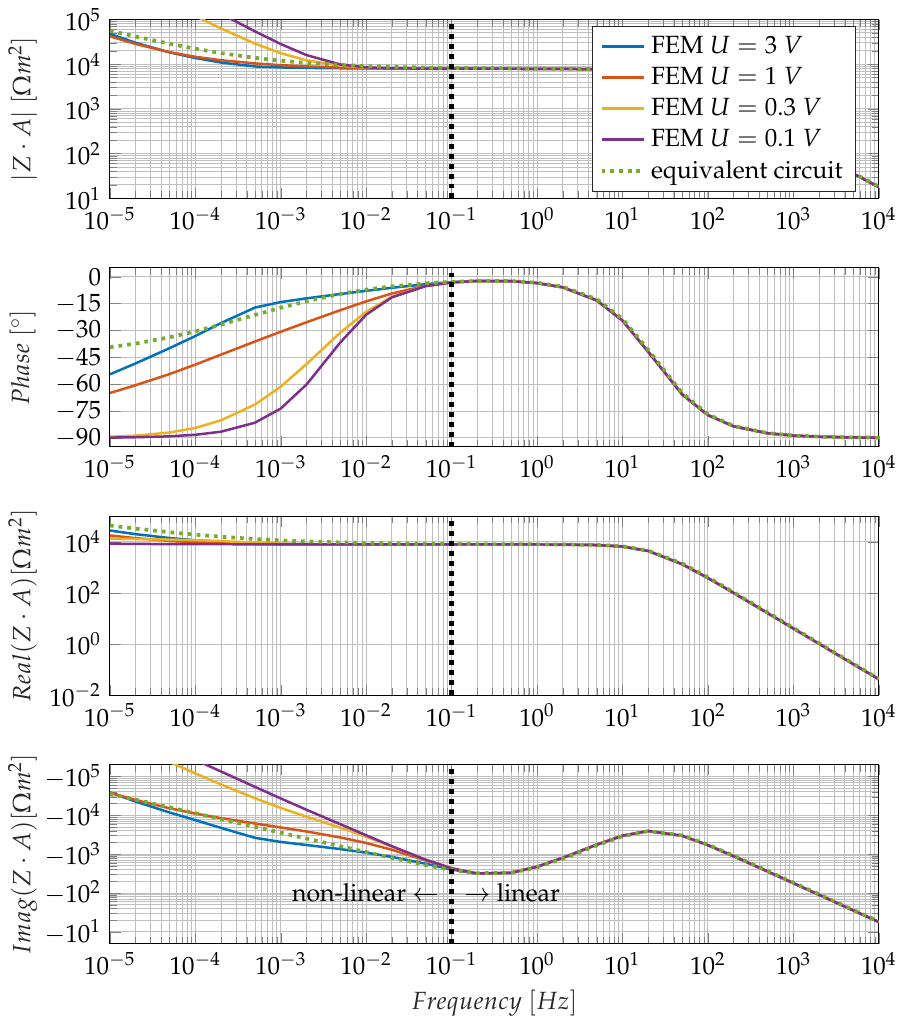
Figure 3. Impedance spectrum of the one-dimensional FEM model. The limit cycles from Figure 2 are marked in the impedance spectrum. The spectrum neglects higher harmonic components and uses the fundamental oscillation of the electrical current for impedance calculation at each frequency. The fitted √ equivalent circuit uses the parameters C = 860nFm − 2 , R 2 = 7910 Ω m 2 , A 2 = 400 Ω Hzm 2 . In contrast to the one-dimensional FEM model considered so far, interdigitated elec- trodes have a predominantly two-dimensional field distribution. In the area of the finger- tips, the field distribution is even three-dimensional. Especially in interdigitated structures with a very large electrode width compared to the gap width, the electric field strengths between the electrodes are considerably larger than the electric field strengths perpendicu- lar to the electrodes. Since the electric field strength is the driving force for ion movement, a distinction must be made between ion movement in the electrode plane and ion move- ment perpendicular to the electrode plane. For this reason, a third branch is introduced in the equivalent circuit diagram, only comprising a Warburg impedance A 3 . The complete equivalent circuit is shown in Figure